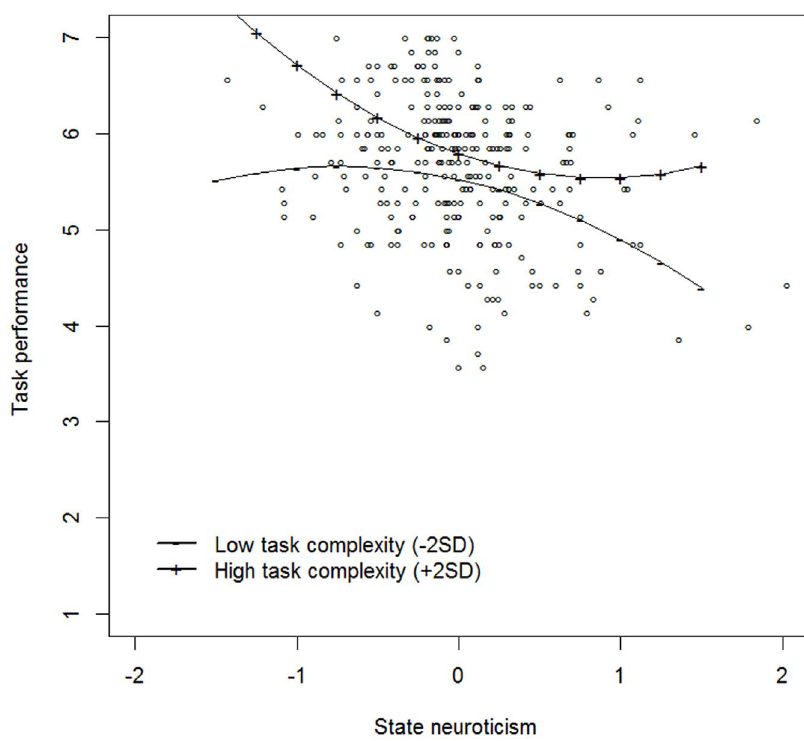
Figure 1. The moderating effect of low ( 2 2 SD ) and high ( + 2 SD ) levels of momentary task complexity on the state neuroticism – task performance relationship (Study 1).